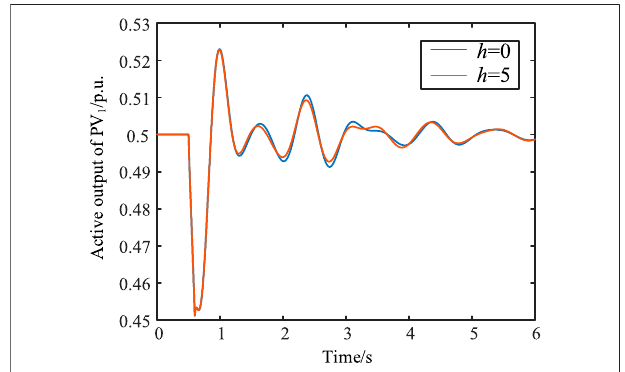
FIGURE 16 | Non-linear simulation results of the active power output of PV 1 when the electrical distance between each of the PV farms and the main grid remains unchanged.